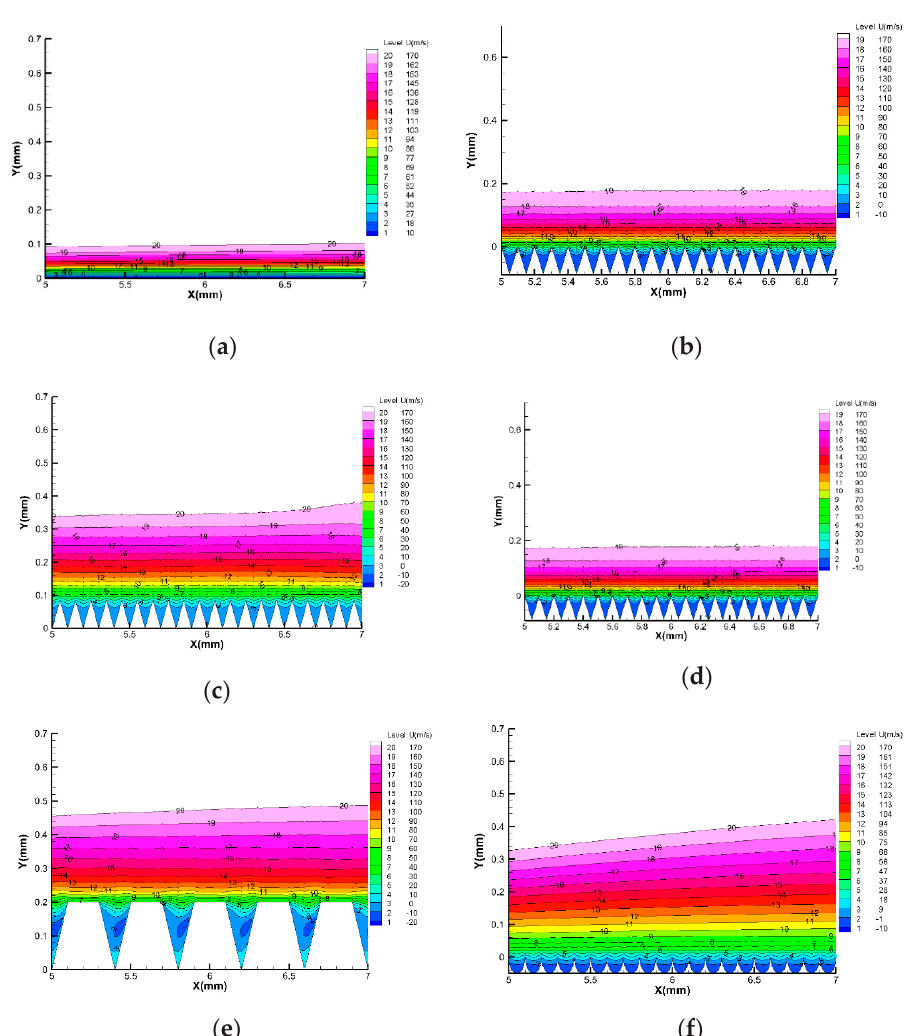
Figure 6. The boundary layer of Mach number 0.5 Ma. ( a ) The smooth flat plate, ( b ) the triangular concave grooves, ( c ) the triangular protrusions, ( d ) the trapezoidal concave grooves, ( e ) the trapezoidal protrusions, and ( f ) the circular concave grooves.